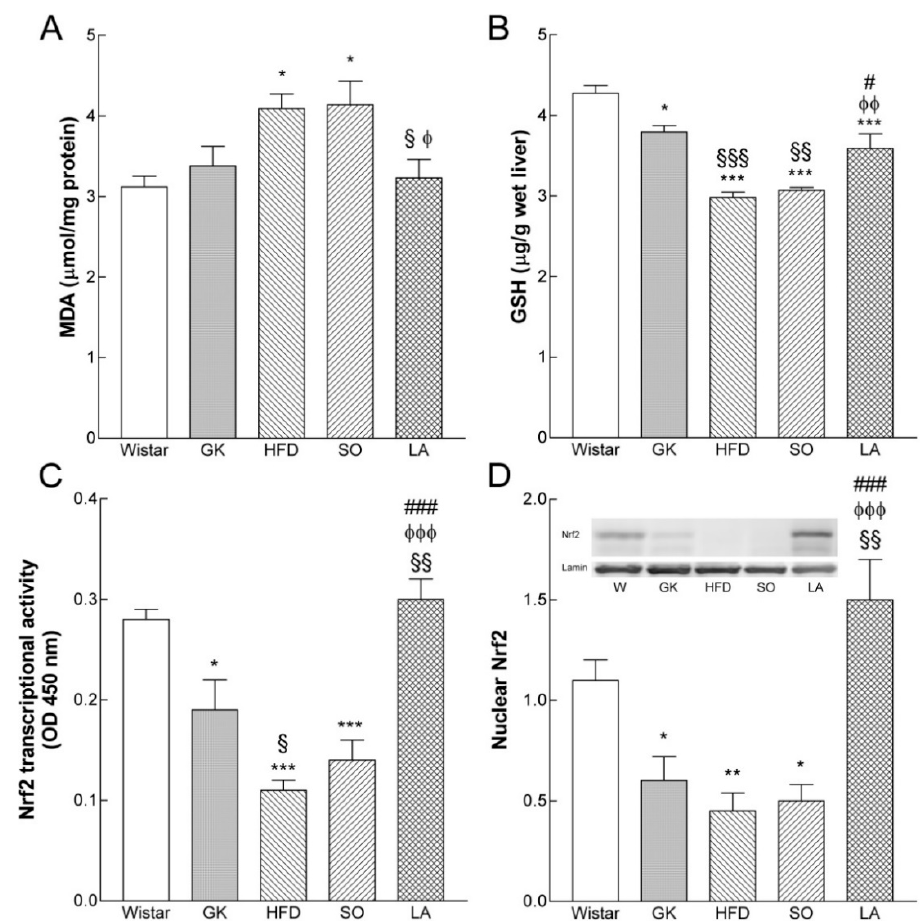
Figure 3. Effects of α -lipoic acid ( α -LA) on lipid peroxidation (MDA), glutathione (GSH), and Nrf2 levels in the liver of Goto-kakizaki (GK) rats fed a high fat diet (HFD) compared with nondiabetic Wistar rats. Diabetes and HFD-induced impairment in the nuclear accumulation of Nrf2 and an increment in lipid peroxidation with concomitant reduction in GSH levels and α -LA prevented these effects. ( A ) Liver malondialdehyde (MDA) levels, ( B ) liver GSH levels, ( C ) the nuclear extracts depicted on panel D were also used for the measurement of Nrf2 DNA-binding activity using a TransAm Binding Assay (Active Motif), ( D ) representative Western blot analysis and average densitometry data (normalized with lamin values) of nuclear Nrf2 protein expression in livers of Wistar, Goto-kakizaki (GK) rats control and GK fed with high fat diet (HFD) with or without vehicle (soybean oil, SO) or α -LA. Data are expressed as mean ± SEM (n = 7 animals per group). * p < 0.05, ** p < 0.01, *** p < 0.001 vs. Wistar group, § p < 0.05, §§ p < 0.01, §§§ p < 0.001 vs. GK group; φ p < 0.05, φφ p < 0.01, φφφ p < 0.001 vs. GKHFD group, # p < 0.05, ### p < 0.001 vs. GK SO group.